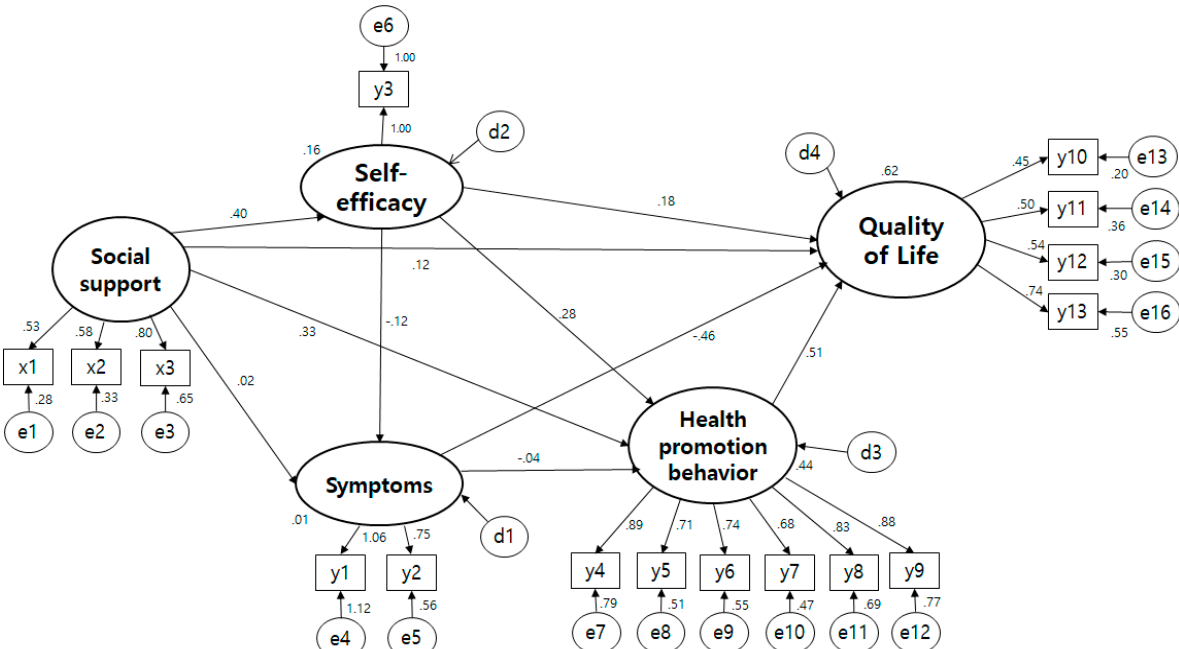
Figure 2. Path diagram hypothetical model. x1 Sinificant support; x2 Family support; x3 Friend sup-